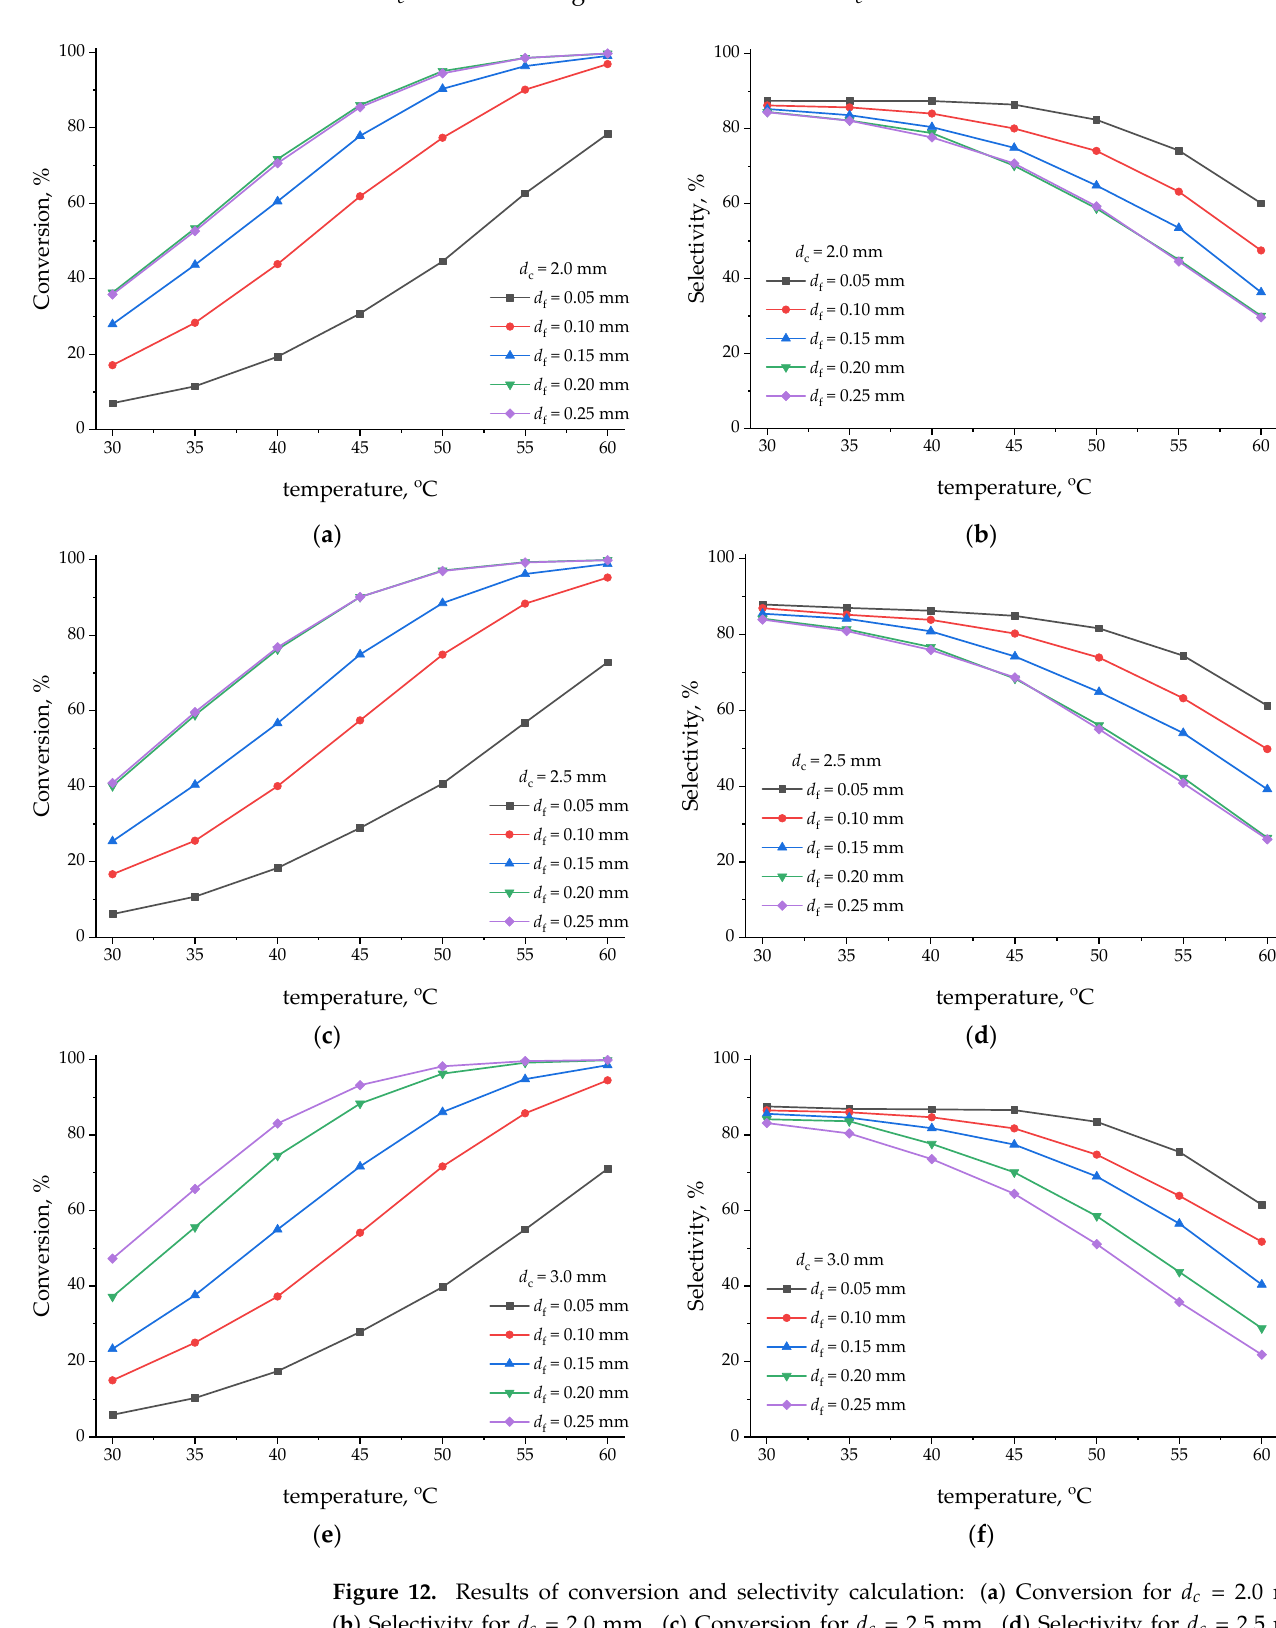
d = 2.5 mm. ( d ) Selectivity for с d = 3.0 mm. с